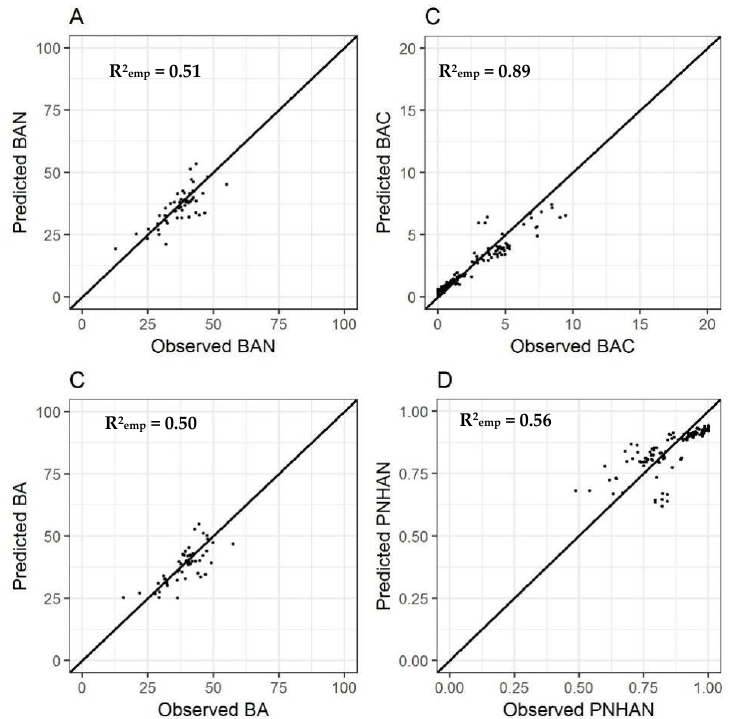
Figure 3. Observed vs. predicted values for ( A ) basal area of Nothofagus species (BAN, Equation (7)); ( B ) basal area of companion species (BAC, Equation (8)); ( C ) total basal area, BA = BAN + BAC; and ( D ) the proportion of number of trees per hectare of Nothofagus species (NHA, Equation (3)). All plots use the Permanent Plot (PP) series.